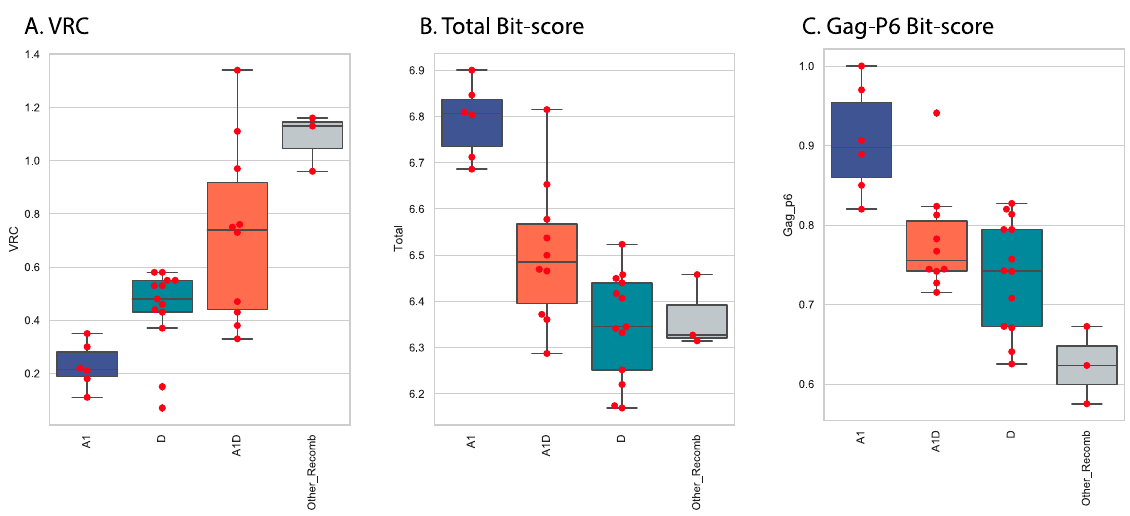
Figure 5. VRC, total domain scores and Gag-p6 domain bit scores by subtype. Scores for the 32 sequences were plotted as a function of the subtype category. For each panel, the median value is indicated by a horizontal line within the box, the top and bottom of the box indicate the interquartile range, individual values are indicated by red markers. Intergroup p values (Welch’s t -test) showed that all pairs were different (A1_VRC, D_VRC, p value = 0.0017; A1_VRC, A1D_VRC, p value = 0.0010; A1_VRC, Other_Recomb_VRC, p value = 0.0008; D_VRC, A1D_VRC, p value = 0.0281; D_VRC, Other_Recomb_VRC, p value = 0.0007; A1D_VRC, Other_Recomb_VRC, p value = 0.0151). ( A ) VRC vs. subtype, ( B ) Total domain bit-score vs subtypes, ( C ) Gag-P6 bitscore vs subtype.